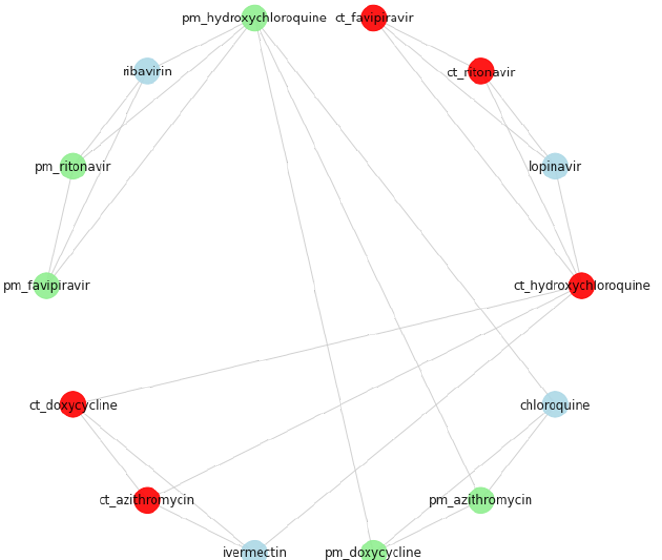
Figure 3. A map of size-four literature cliques and clinical trial cliques resulting from the workflow. The green nodes are the components of cliques detected from the biomedcial publications; they are prefixed with “pm”. The red nodes are the matching counterparts extracted from the clincical trial datasets; they are prefixed with “ct”. The lightblue nodes are part of the clique but do not have a match and, therefore, cannot be part of the